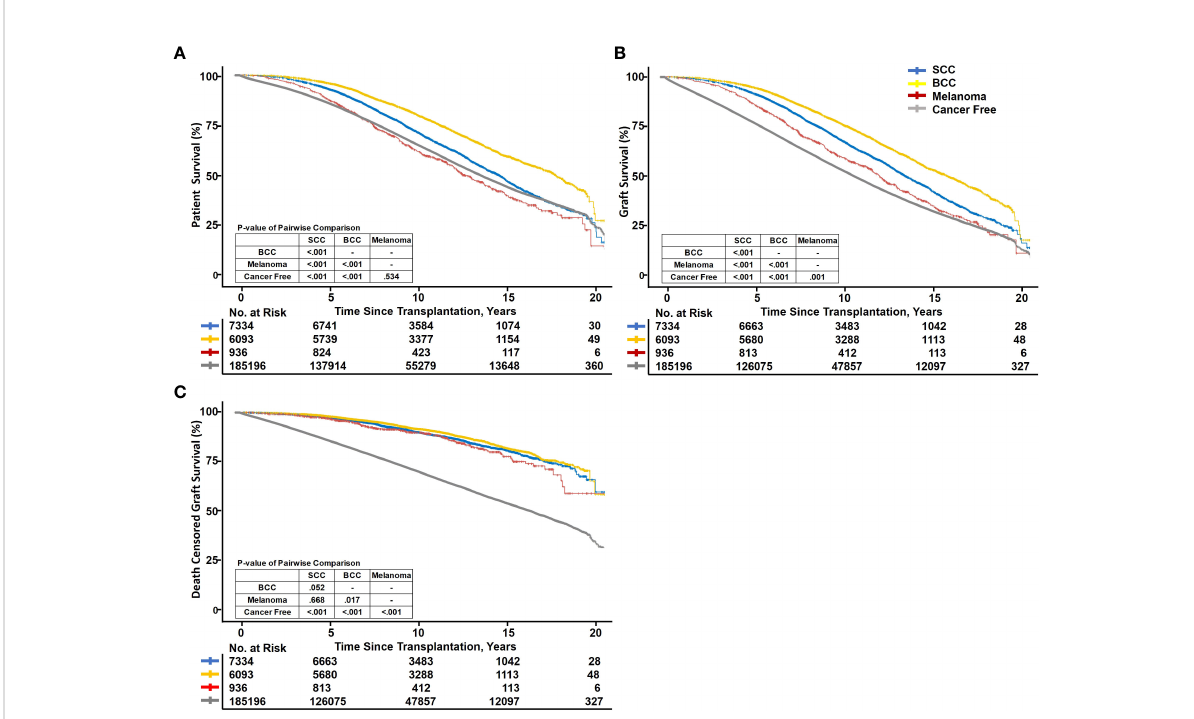
FIGURE 2 Kaplan – Meier survival curve fi t of recipient and graft survival. SCC, squamous cell carcinoma; BCC, basal cell carcinoma. Kaplan – Meier curves showing patient survival (A) , graft survival (B) , and death-censored graft survival (C) between PTSC and cancer-free kidney transplant